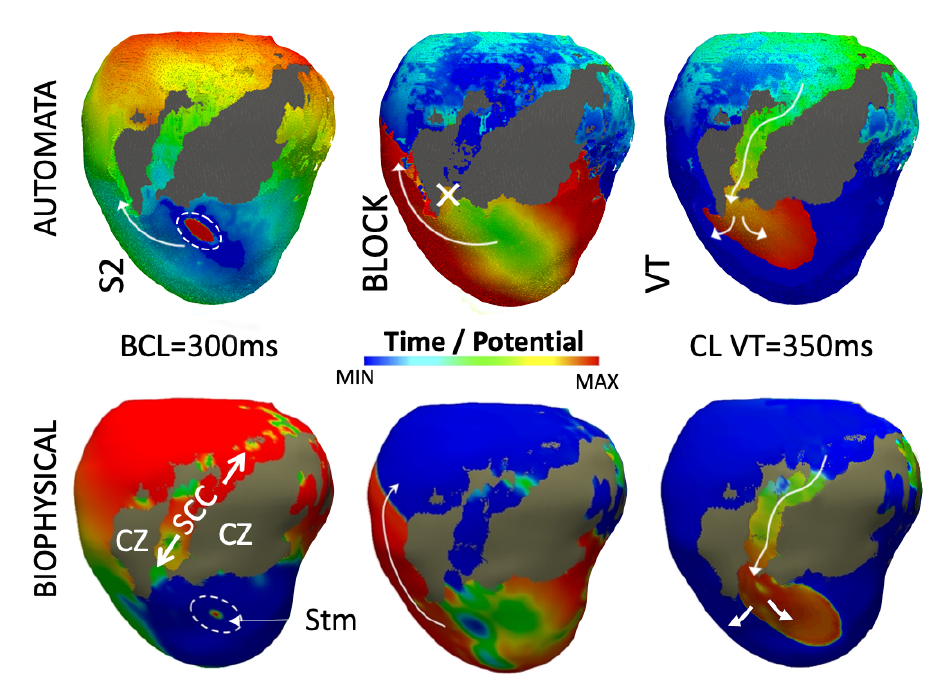
Figure 9. Simulation time instants (ms) for CA and biophysical model. VT episode resulted from applying an S1–S2 protocol at the location labeled as ’Stm’. First row shows the endocardial layer (light gray) and the activity in the BZ region in the CA model (CZ and healthy tissue are transparent), while second row shows the equivalent in the biophysical model with all tissue types visible (CZ in dark gray color). Colors in the CA simulation represent time (ms), and in the biophysical simulation represent potential (mV). A conduction block can be observed a few milliseconds after the S2 (white cross). VT is subsequently sustained across the SCC. White arrows show the direction of the